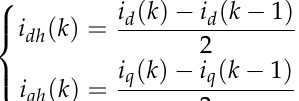
Figure 1. High-frequency signal and fundamental signal.